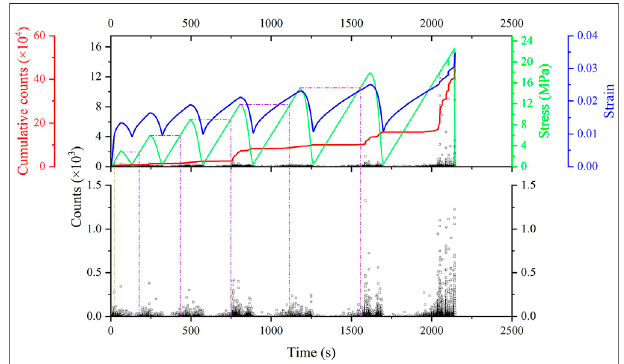
FIGURE 7 | The relationship between the axial stress, axial strain, acoustic emission, and uniaxial constant amplitude cyclic loading.